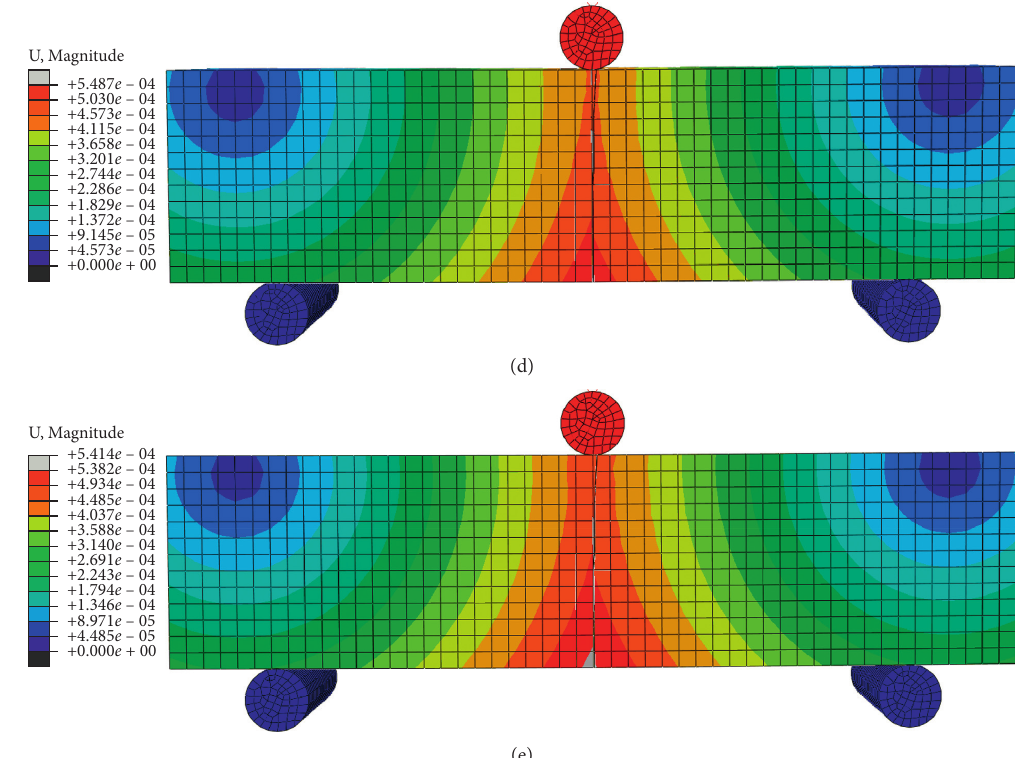
Figure 10: Failure forms of beams under different loading rates in finite element simulation. (a) 1 mm/s. (b) 0.1 mm/s. (c) 0.01 mm/s. (d) 0.001 mm/s. (e) 0.0001 mm/s.